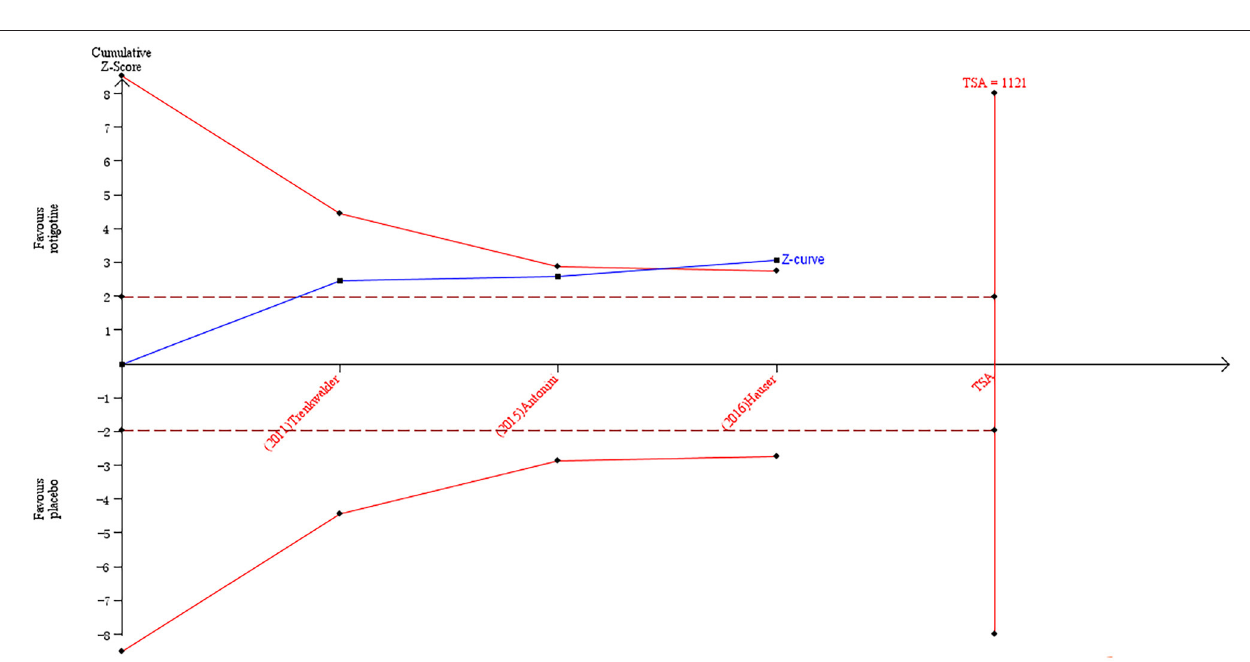
FIGURE 7 | Trial sequential analysis of the cumulative meta-analysis of the effect of rotigotine vs. placebo on mood/apathy score of Parkinson’s Disease Non-motor Symptom Assessment Scale in Parkinson’s disease patients.